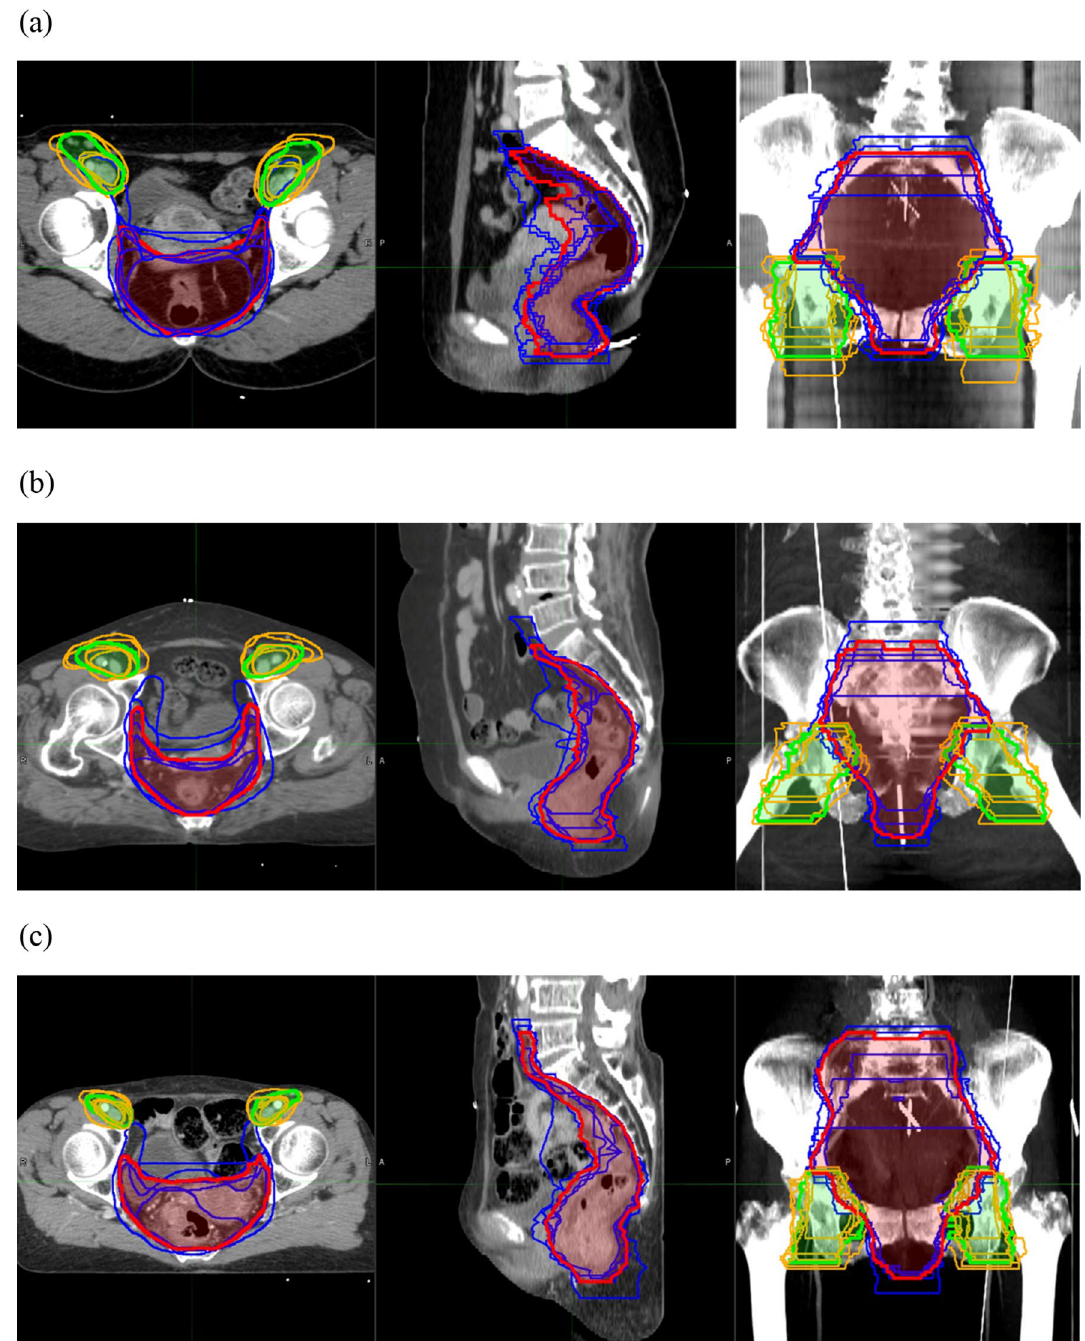
Figure 1. CTV-pelvis (dark blue) and CTV-inguinal (orange) of 7 radiation oncologists and STAPLE generated contour of CTV-pelvis (red) and CTV-inguinal (green) with confidence level of 80%. (a) Patient 1; (b) Patient 2; (c) Patient 3. Figures were generated using MIM 6.9.7 (MIMVista Corp, Cleveland,